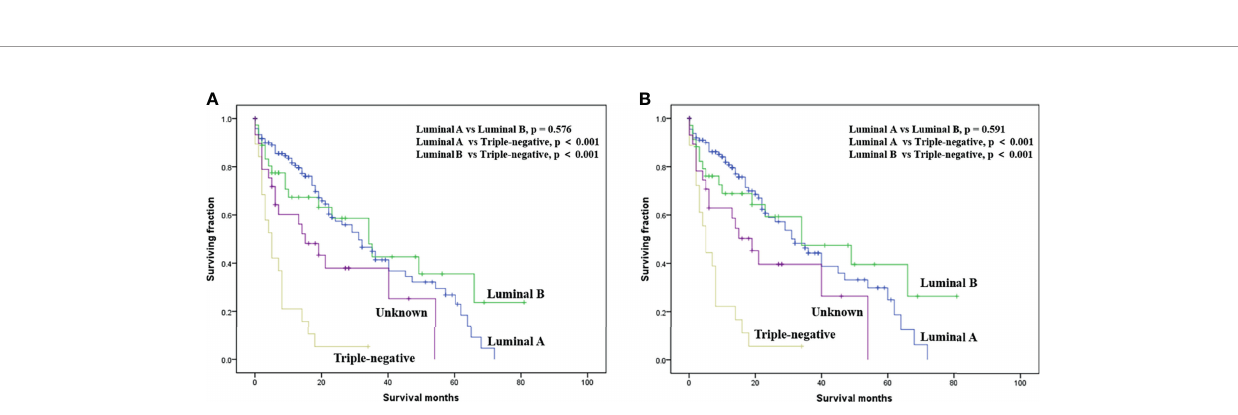
FIGURE 3 | Kaplan – Meier method-estimated OS (A) and CSS (B) male breast cancer with bone metastasis strati fi ed by tumor subtype. (OS, overall survival; CSS, cancer-speci fi c